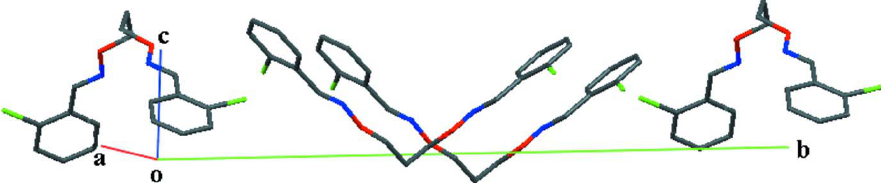
The molecular structure of the title compound with atom numbering scheme [Symmetry codes: - x + 1, - y , z ]. Displacement ellipsoids for non-hydrogen atoms are drawn at the 30% probability level.